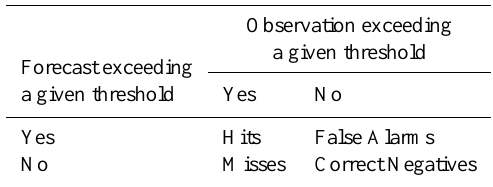
Table 3. Contingency table of binary events for categorical verifi- cation